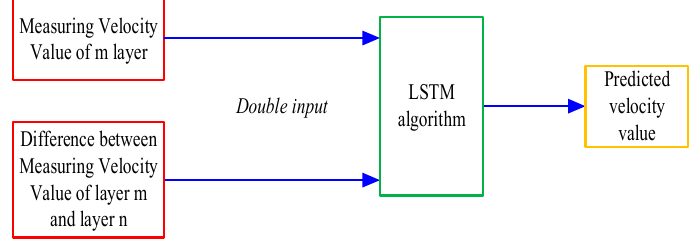
Figure 2. Diagram of a traditional single input tidal current prediction method.